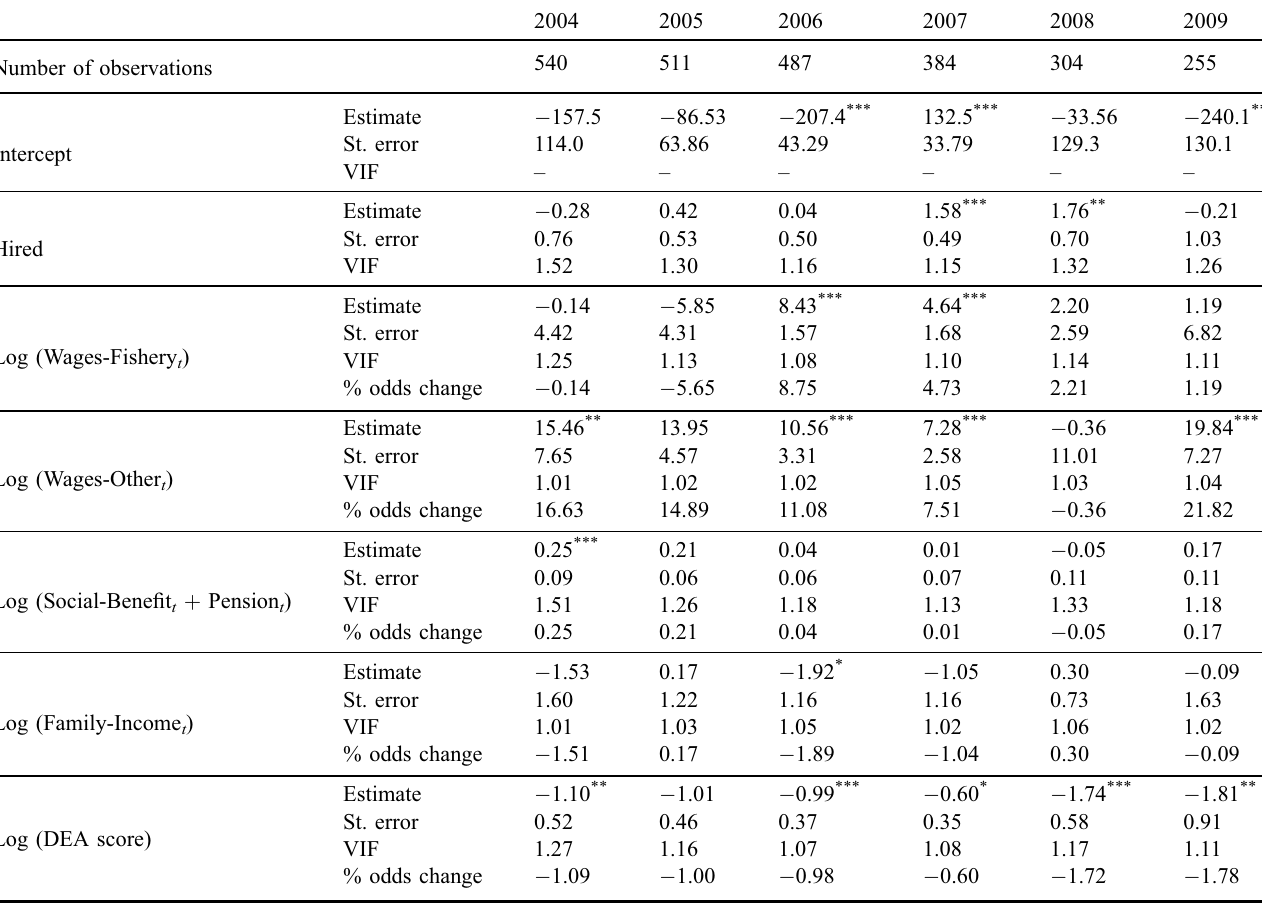
Table 5. Parameter estimates from the logit regression including fi shery wages in year t, regressing the probability of leaving against the variables indicated in Table 3 (and Eq. (1) ). Standard errors of the parameters and variance in fl ation factors (VIFs) are included. Furthermore, the table displays the % change in probability of leaving the fi shery when the explanatory variable changes by